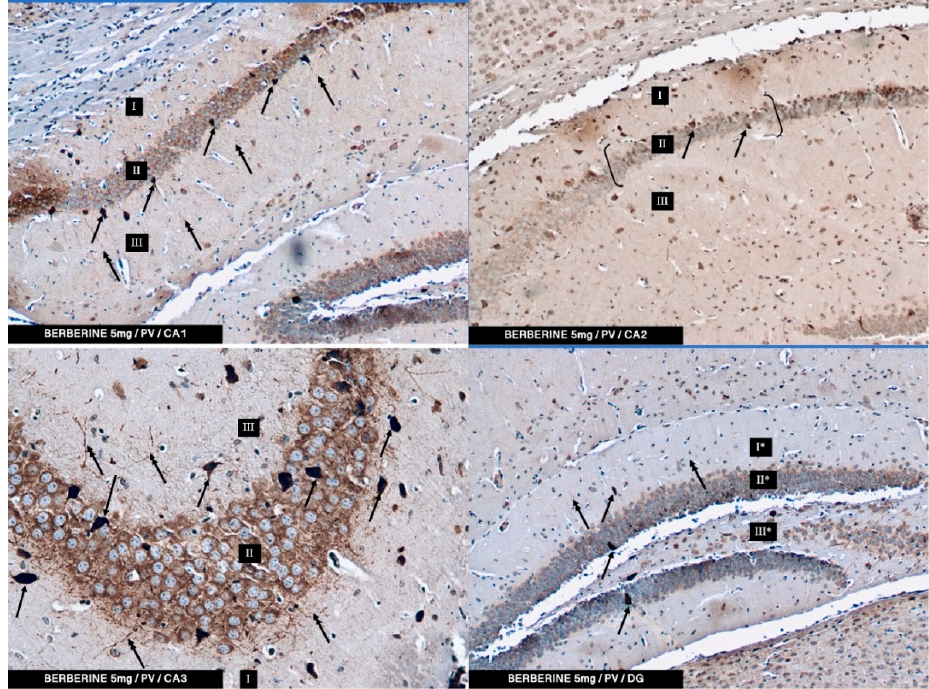
Figure 5. The experimental group treated with 5 mg/kg (i.p.) of BBR. The immunoreactivity of the PV-IR of moderate neurons of CA1–CA3 mouse hippocampal fields and DG of the hippocampus is observed. ( I : the marginal layer, II : the pyramidal layer, III : the multiform layer; the arrows indicate PV-IR neurons ( single arrow ) and PV-IR fibers ( double arrow ) of the hippocampus; magnification ×